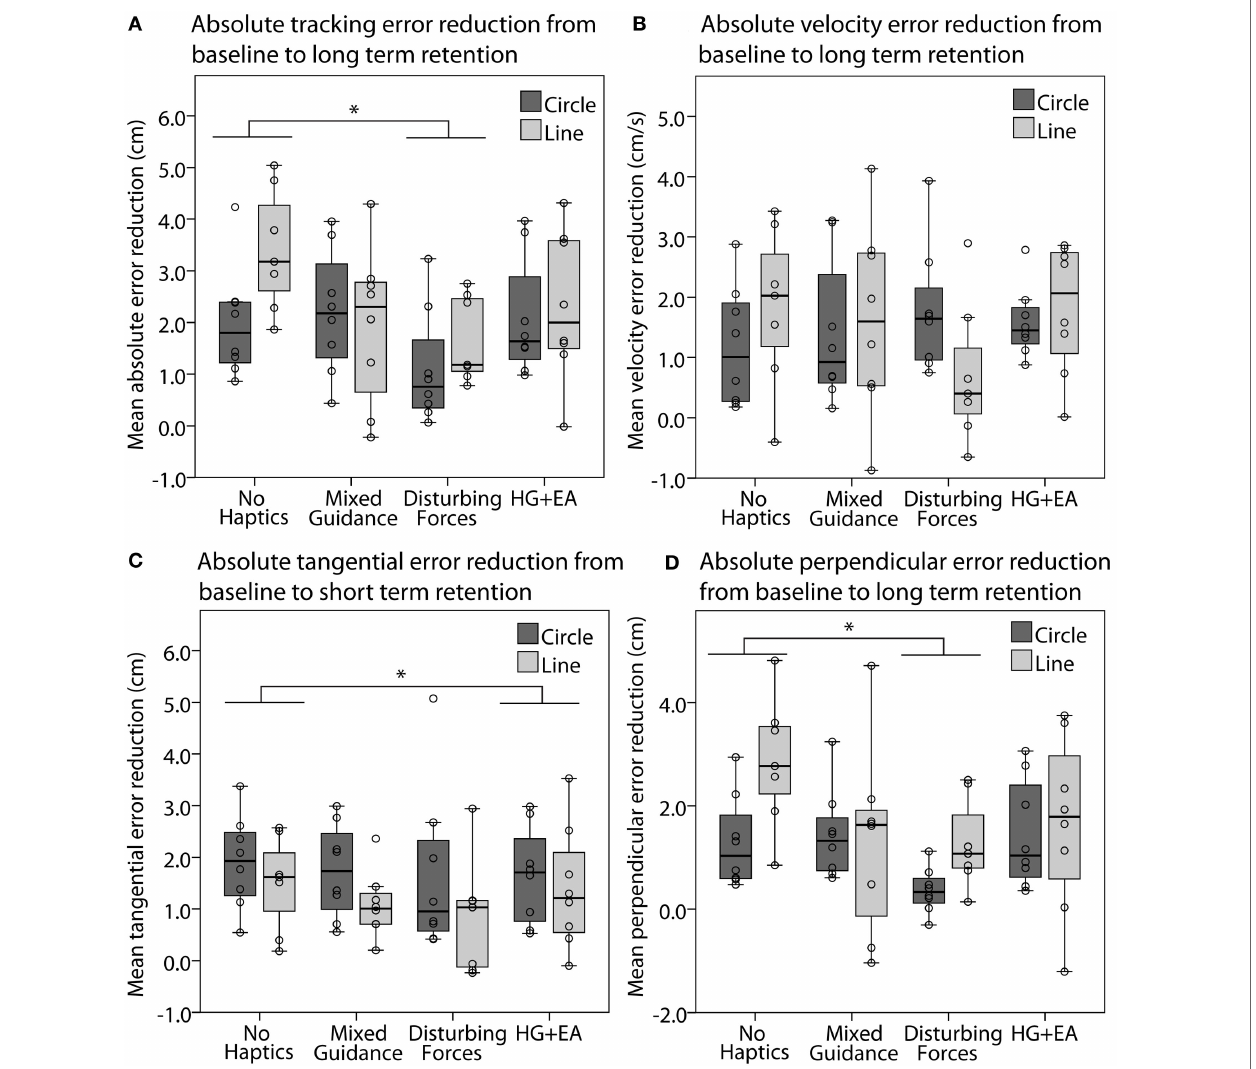
FIGURE 8 | Effect of training strategies on learning . (A) Box-plot of mean absolute tracking error reduction from baseline to long-term retention for the circle (dark gray) and line (light gray) tasks. (B) Box-plot of mean absolute velocity error reduction from baseline to long-term retention, in the circle and line tasks. (C) Box-plot of mean absolute tangential error reduction from baseline to short-term retention, in the circle and line tasks. (D) Box-plot of mean absolute perpendicular error reduction from baseline to long-term retention, in the circle and line tasks. * p < 0.05. Horizontal lines are medians, boxes show the interquartile range (IQR), error bars extent (cid:6) 1.5 IQR. Individual data points are plotted as circles.